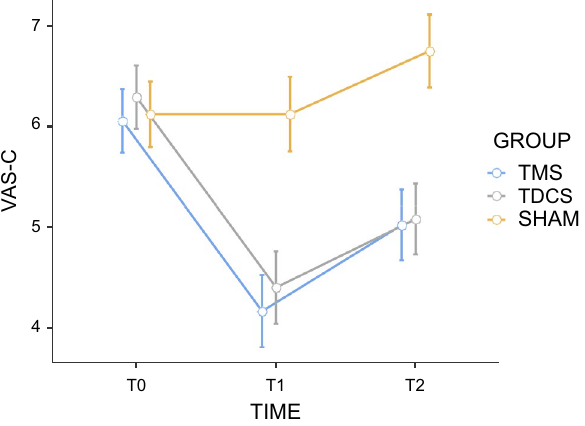
Figure 3. Effects of active repetitive transcranial magnetic stimulation (rTMS), active transcranial direct- current stimulation (tDCS), and sham stimulation on average continuous pain intensity (VAS). The scores were obtained before the first stimulation session (T0), after the 5th consecutive stimulation session (T1) and 30 days after (T2). For the sake of simplicity, and as the effects of sham rTMS and sham tDCS were remarkably similar regardless of the order in which they were conducted, we present the mean values grouped into a single sham- stimulation group. Error bars indicate standard error of the mean. VAS Visual Analogic Scale.